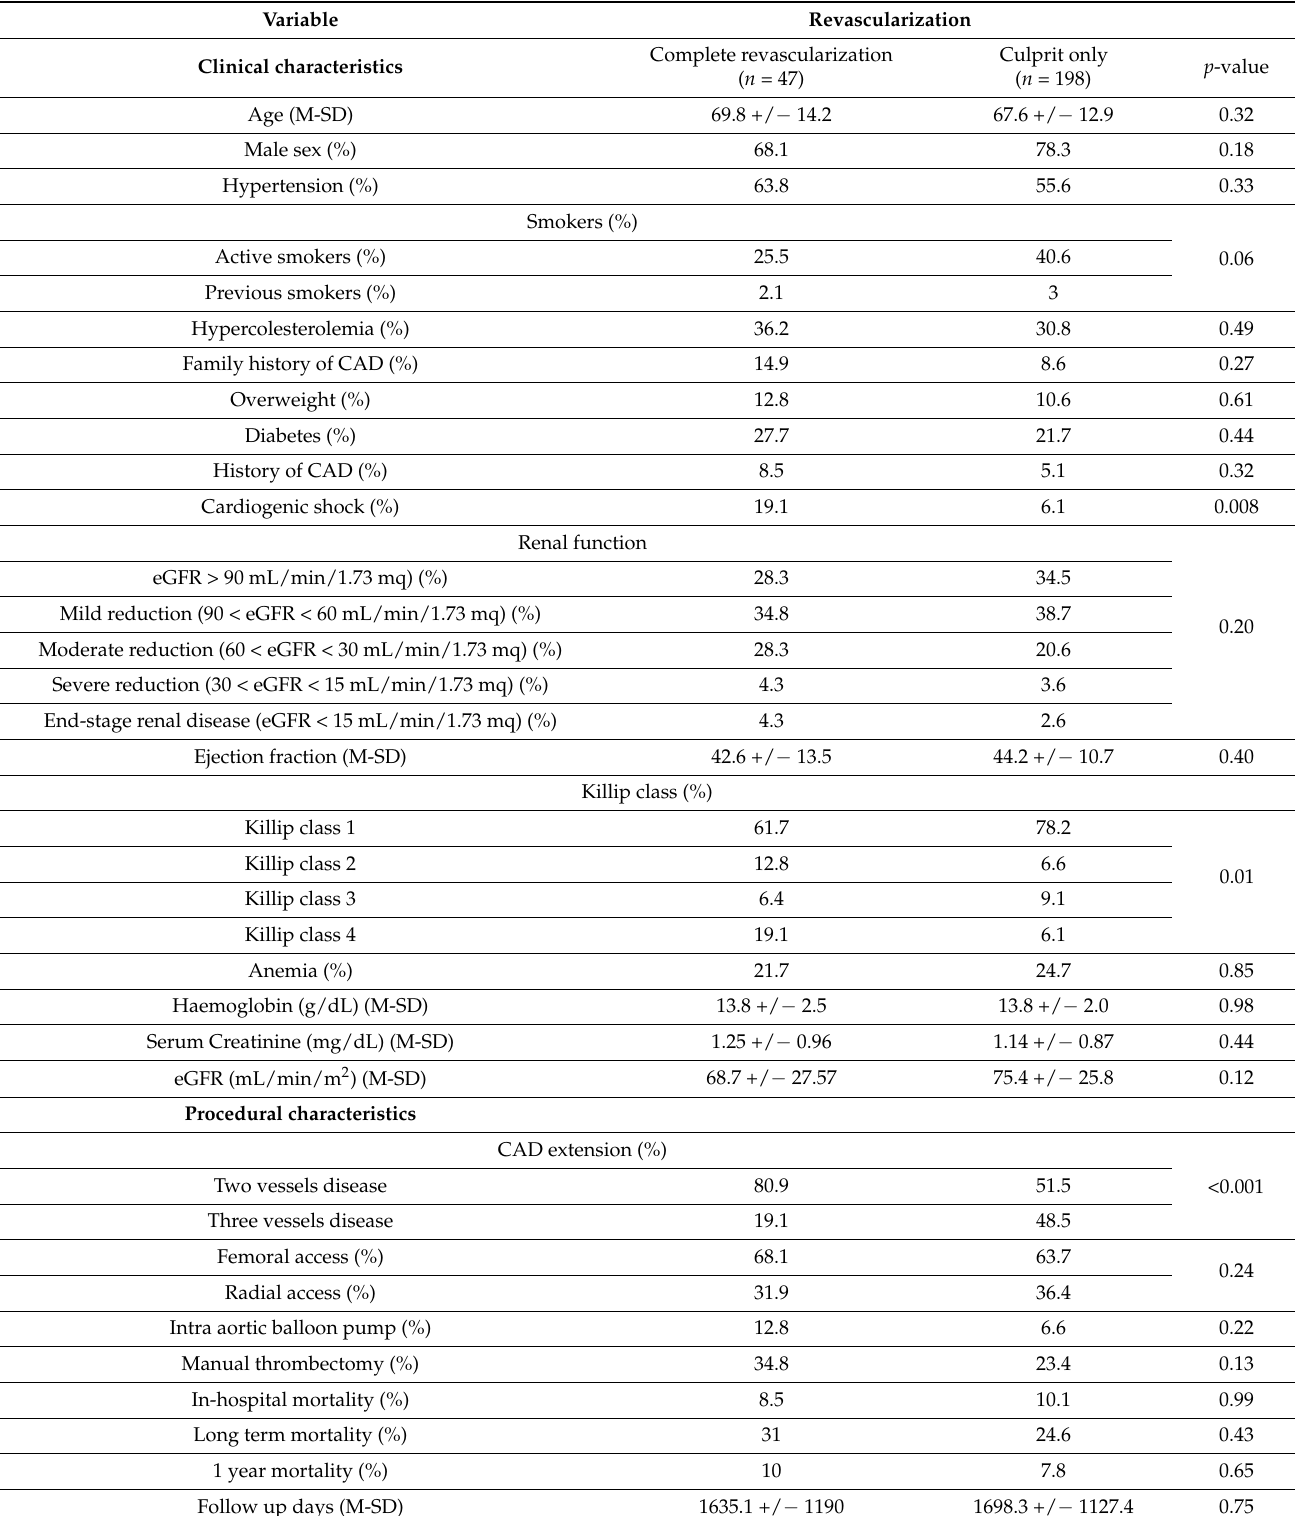
Table 3. Clinical and procedural characteristics of patients with